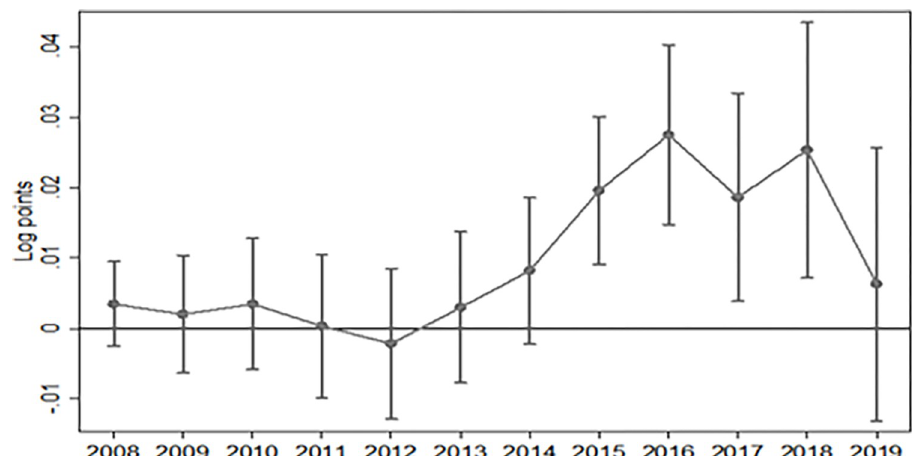
Fig 1. Parallel trend test results. Note: During the period from 2008 to 2014, due to the confidence interval including zero value, the policy coefficient is not statistically different from zero, that is, in Formula (1) β 1 cannot reject the original hypothesis significantly. This indicates that there is no significant difference in the innovation effect between the treatment group cities and the control group cities before the pilot policy, so it passes the parallel trend test.